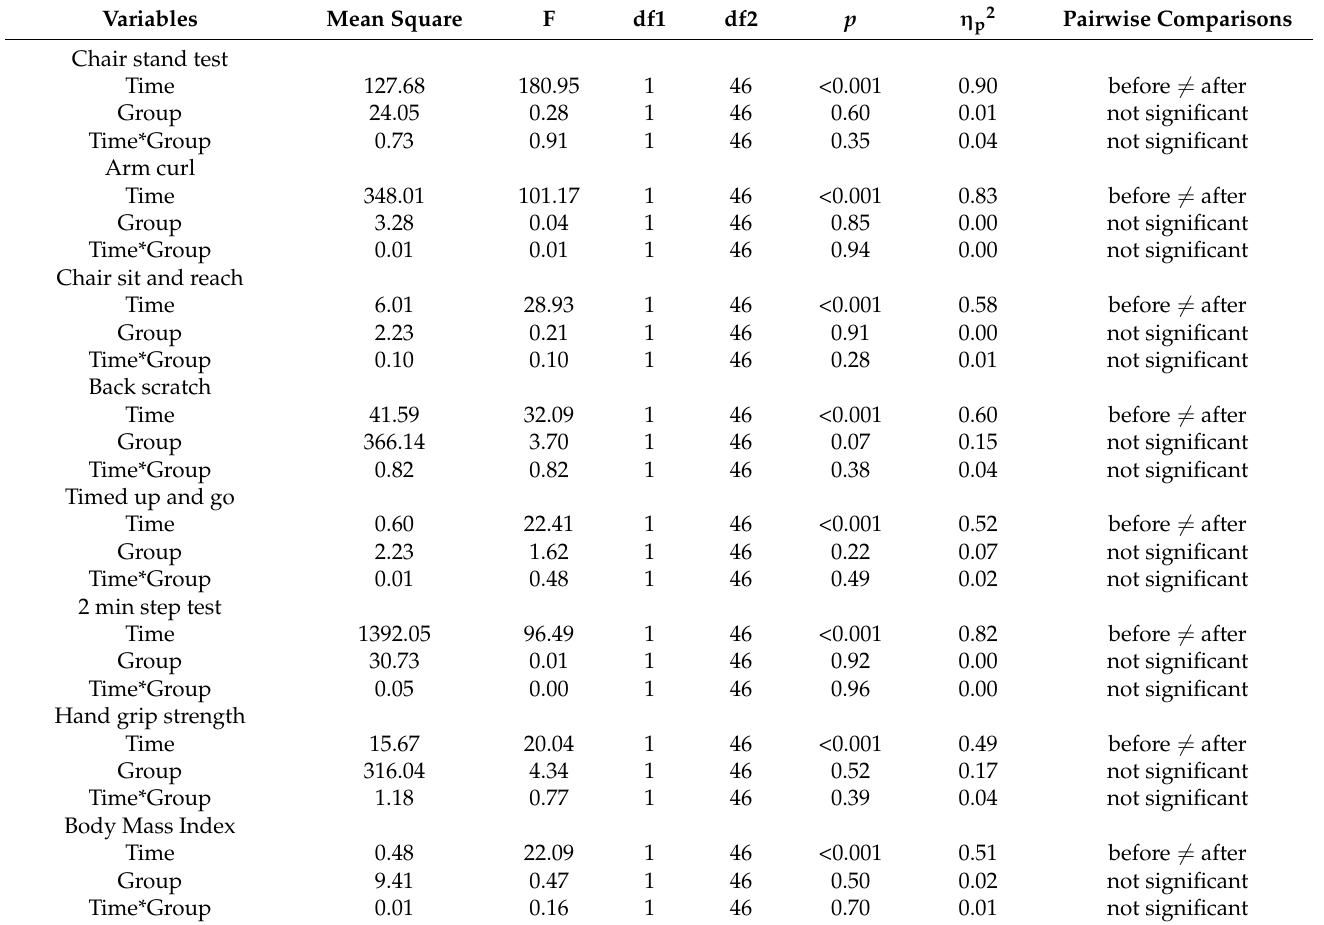
Table 3. Descriptive statistics of each group at baseline and after exercise